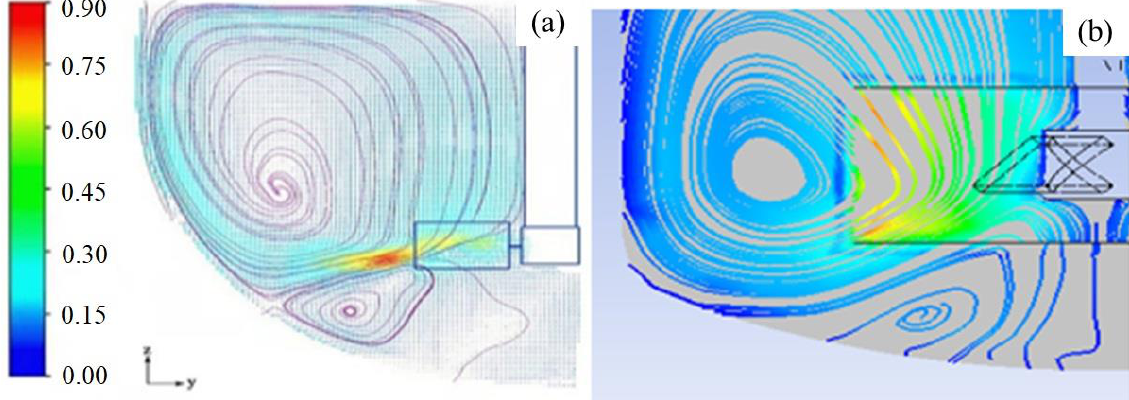
Figure 2. The streamline diagram of PIV ( a ) and CFD ( b ).